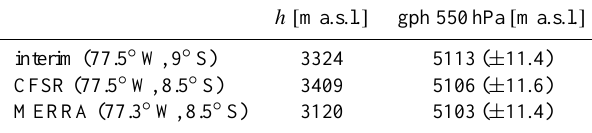
Table 1. Specifications of the reanalysis data grid points applied as predictors: coordinates, surface heights ( h ), and mean geopotential heights (gph), with standard deviations in brackets, during the in- vestigation period (all values are in meters above see